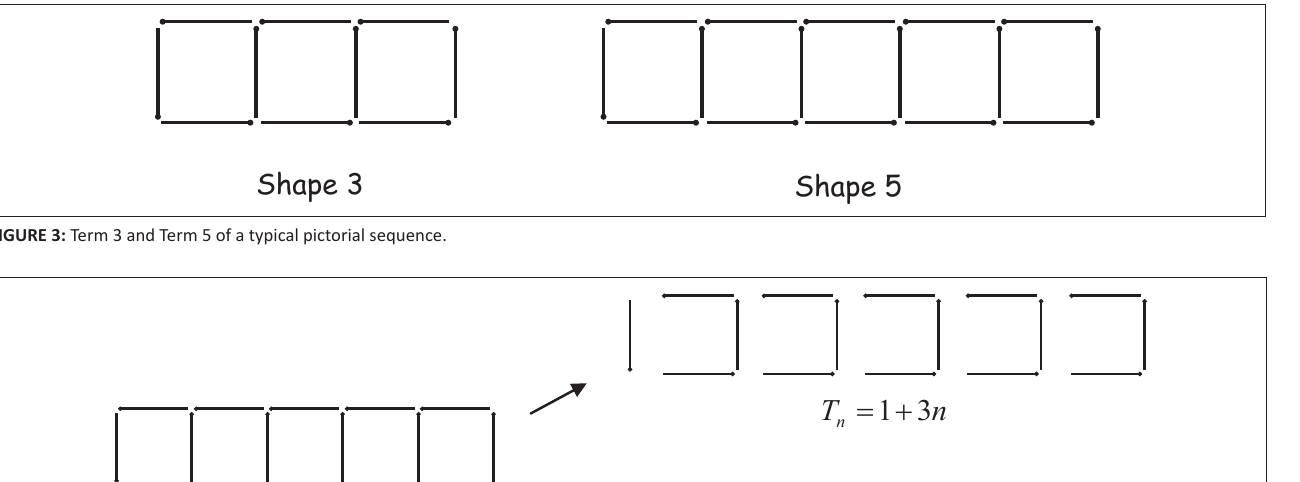
FIGURE 3: Term 3 and Term 5 of a typical pictorial sequence. FIGURE 4: Local visualisation of Term 5. FIGURE 4: Local visualisation of Term 5.